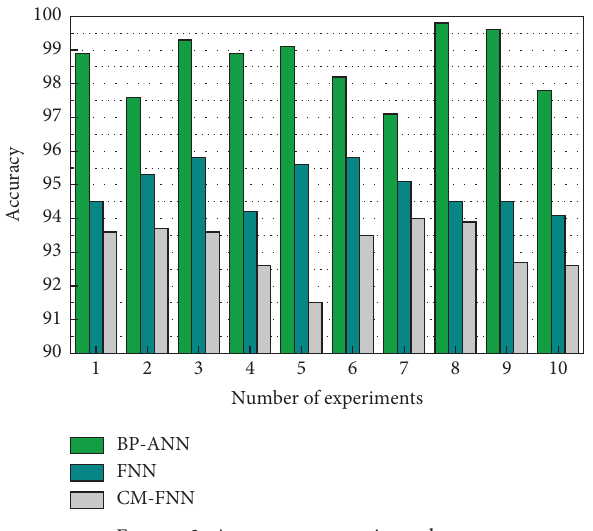
Figure 3: Accuracy comparison